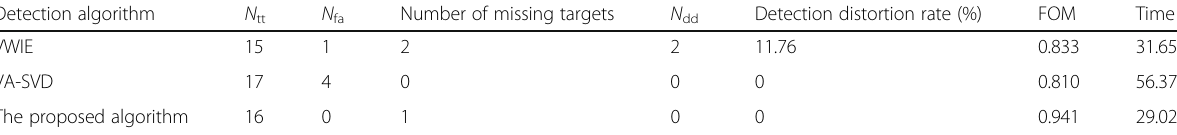
Table 1 Comparison of detection performance among the three detection algorithms Detection algorithm